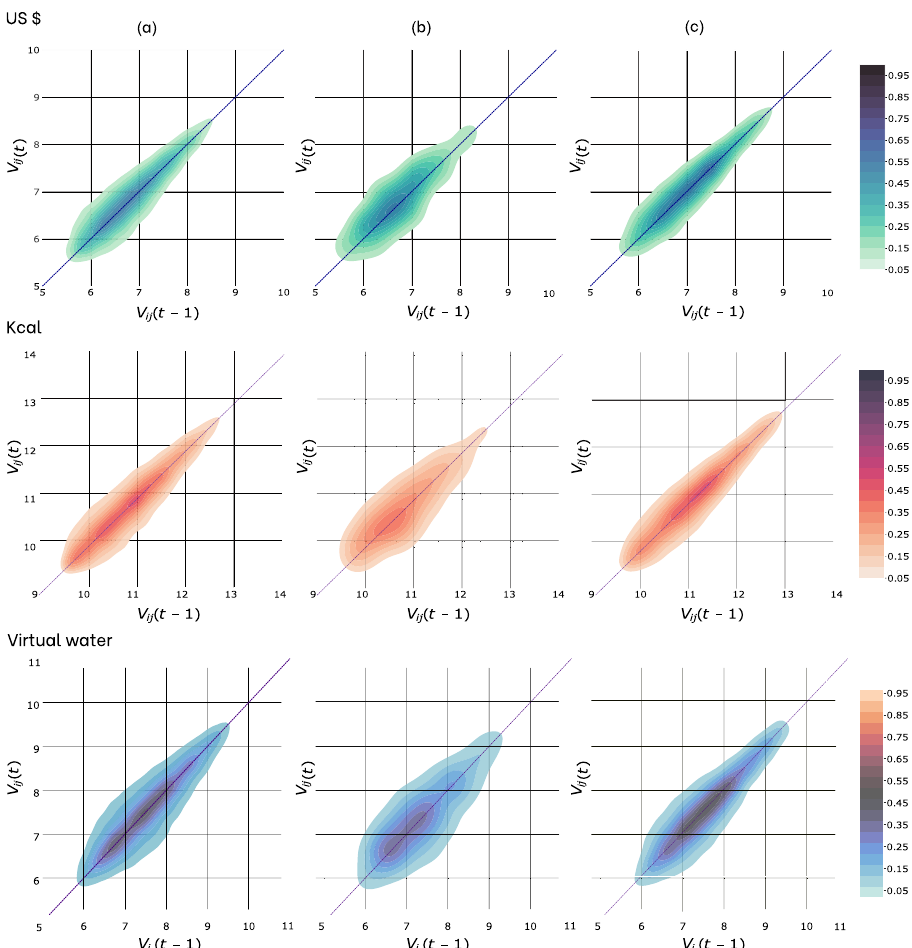
Figure 3. Kernel Density scatterplot between trade flows of cereals at time t (on the y-axis) and time t − 1 (on the x-axis) for the three different sets: No trade agreements (column a ), Operational Activation in t ( b ), and Trade agreement in t − 1 and t ( c ). Panels in the first, second and third row refer to flows in US$, Kcal, and virtual water (m 3 ), respectively. Flow values are shown on a logarithmic scale. The color bar indicates probability densities, and the bisector is highlighted. Notice (i) the higher volumes in the case of flows covered by trade agreement and (ii) a a less relevant increase in volume when the flows are seen in the virtual water